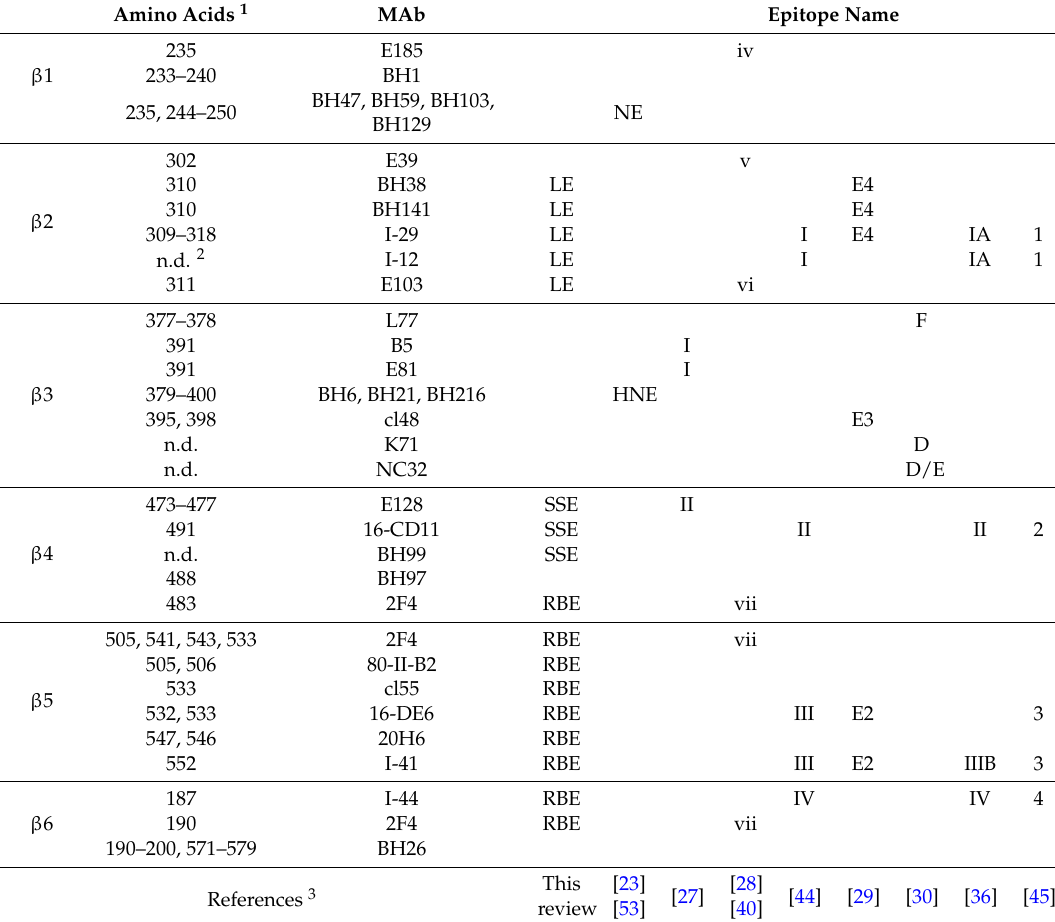
Table 1. Relationships between epitopes and